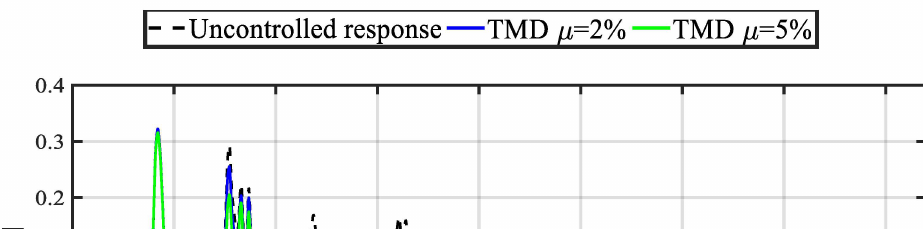
Figure 14. Performance of the structure equipped with TMDs with average design parameters subjected to San Fernando